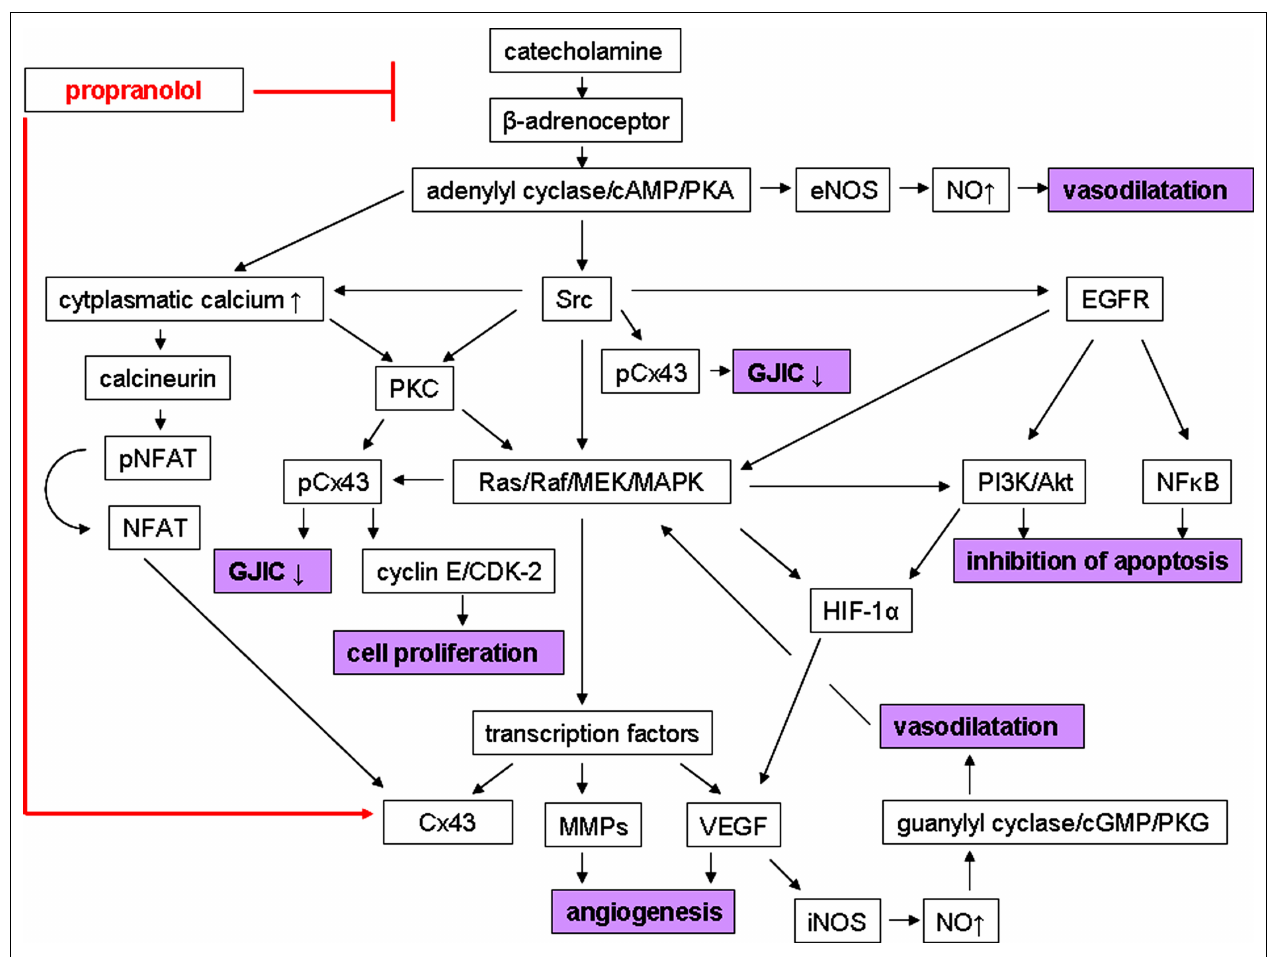
FIGURE 1 | Possible mechanisms of action of propranolol in infantile hemangiomas (IHs). In the absence of the β -adrenoceptor blocker a catecholamine-induced stimulation of the β -adrenoceptor activates several signaling pathways, leading to the pathophysiology of IH.This includes signal cascades, causing (1) angiogenesis via induction of the expression of proangiogenic factors likeVEGF and MMPs (2) vasodilatation via formation and release of NO, (3) inhibition of apoptosis, and (4) reduction of GJIC and stimulation of cell proliferation, respectively, via affecting connexin expression and phosphorylation. In contrast, propranolol treatment results in inhibition of angiogenesis, stimulation of vasoconstriction, triggering of apoptosis, increase of GJIC, and prevention of cell proliferation via blockade of these β -adrenoceptor-mediated pathways, and thus leading to regression of IHs. Furthermore, propranolol could affect connexin expression independently